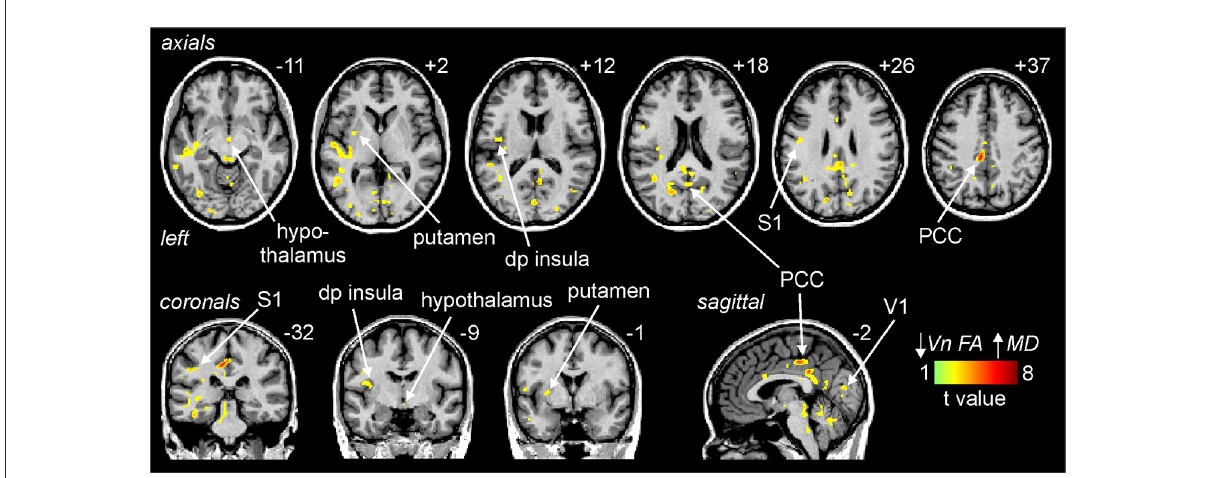
FIGURE4 Areas above the brainstem in which reductions in trigeminal nerve fractional anisotropy (FA) were significantly correlated with increases in above the brainstem mean diffusivity (MD) assessed in migraine ( n = 38) and control participants ( n = 38). Significant clusters are overlaid onto a mean T1-weighted anatomical image. Slice locations in Montreal Neurological Institute (MNI) space are indicated to the top right of each slice. Note that MD was significantly correlated to nerve FA in the posterior cingulate cortex (PCC), primary somatosensory cortex (S1), dorsoposterior insula (dp insula), hypothalamus, putamen and the primary visual cortex (V1).